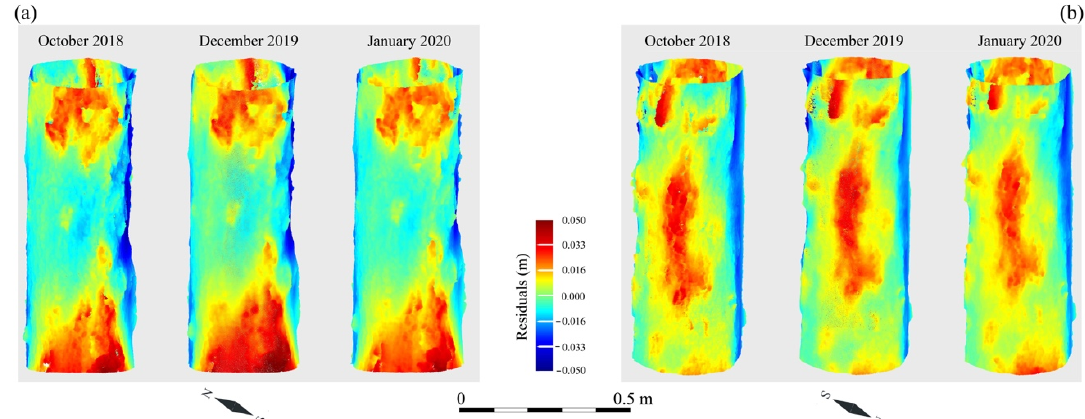
Figure 8. Evolution in time of the geometrical anomalies computed as residuals compared to meshed cylinders fitted to the unified clouds derived respectively from the October 2018, December 2019, and January 2020 CRP reliefs; ( a ) view from the southwest, ( b ) view from the northeast.